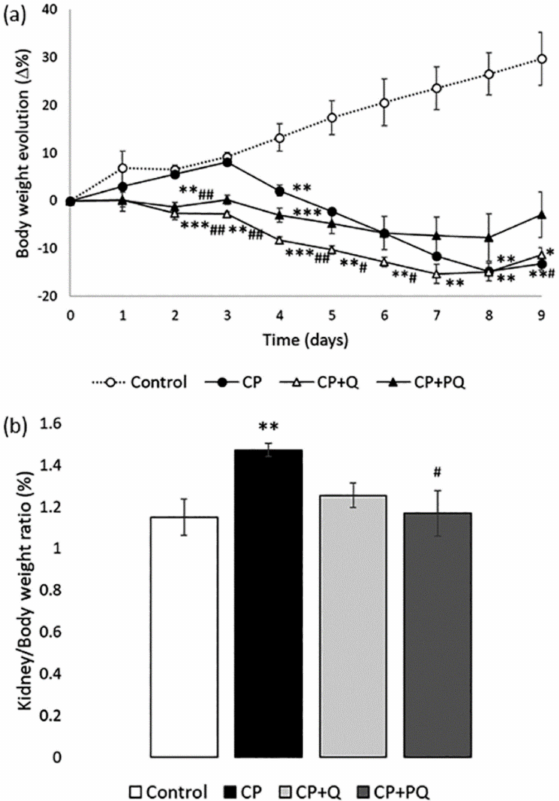
Figure 2. Evolution of general health status. ( a ) Percentage variation in body weight through the experiment; ( b ) Kidney/body weight ratio at day 9. Values are expressed as the mean ± SEM ( n = 3–5 per group). * p < 0.05; ** p < 0.01; *** p < 0.001 vs. Control group. # p < 0.05; ## p < 0.01 vs. CP group. CP: cisplatin (6.5 mg/kg, i.p.) on day 3; CP + Q: quercetin (50 mg/kg, i.p.) for 9 days and cisplatin (6.5 mg/kg, i.p.) on day 3; CP + PQ: P-quercetin (100 mg/kg, i.p.) for 9 days and cisplatin (6.5 mg/kg, i.p.) on day